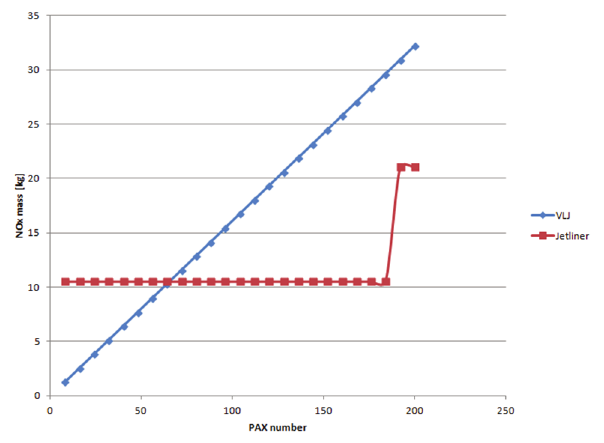
Fig. 5. Comparison between VLJ and jetliner’s NOx total emission per number of passengers Taking into consideration, that about 80% of aircrafts registered in USA are general aviation (for non-commercial purposes) it is advisable to extend the ICAO certification process and consider VLJ’s engines in emission standards. Some of the airports around the world, especially big ones are charging aircraft carriers for their airplane’s emission Fig. 3. Comparison between VLJ and jetliner’s CO and NOx emission per and noise. For example, at the Charles-de-Gaulle airport passenger there are five emission classes and six acoustics groups of aircrafts (Fig.